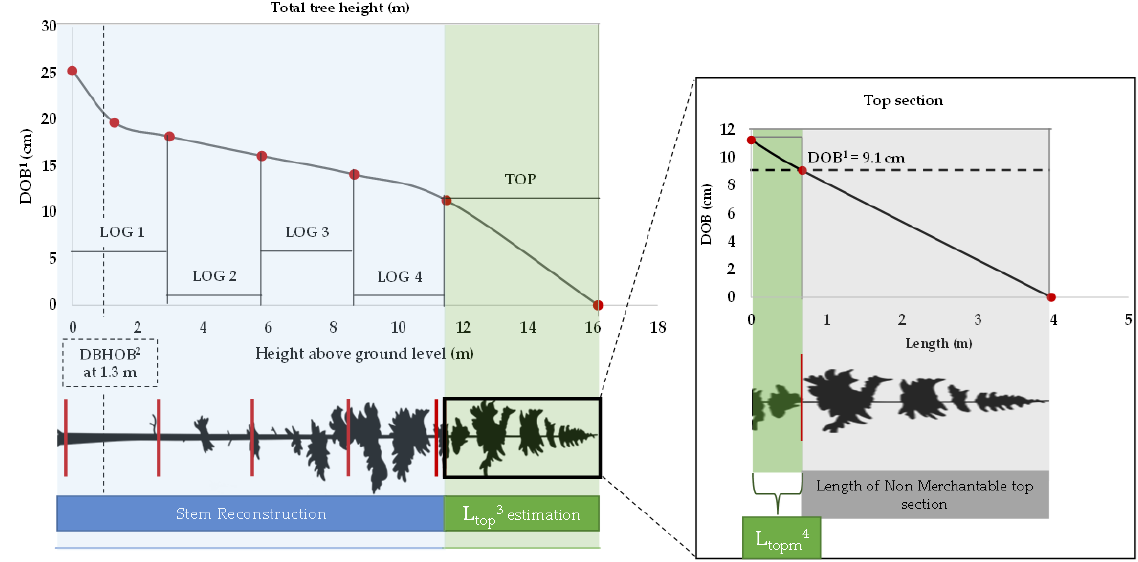
Figure 4. Reconstruction and estimation of top length, total length, and merchantable top length 1 DOB: Diameter over bark; 2 DBHOB: Diameter at breast height over bark; 3 Ltop: Top length; 4 Ltopm: (Merchantable top length).